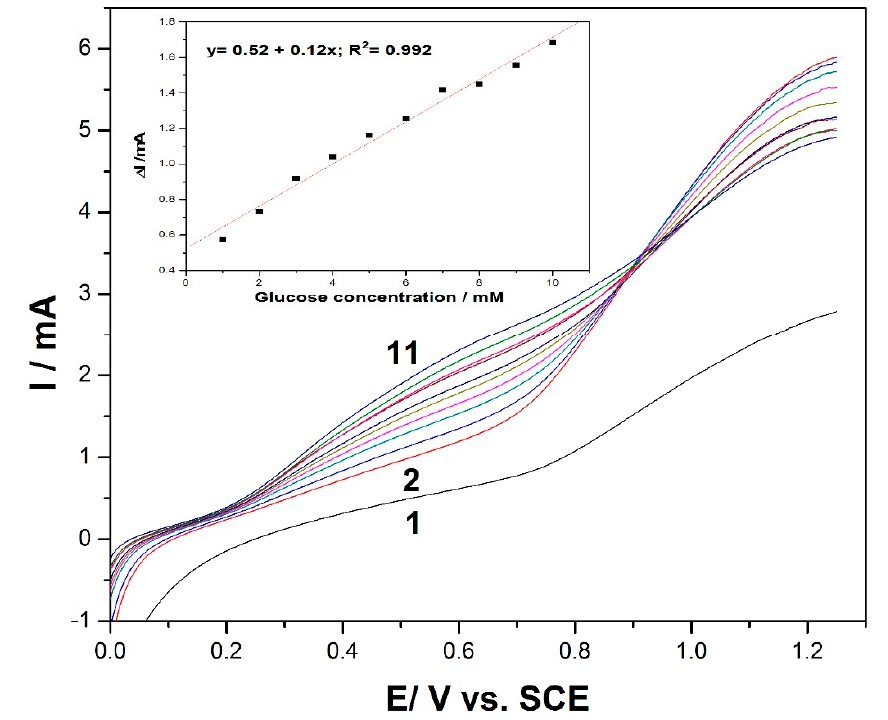
Figure 3. Linear scan voltammetry (LSV) recordings at the MWCNT-CuBTC composite electrode in 0.1 M of NaOH supporting electrolyte (curve 1) and in the presence of various glucose concentrations, ranging from 1 mM to 10 mM (curves 2–11). The inset contains calibration plots of the current recorded at +0.6 V/SCE versus the glucose concentration.